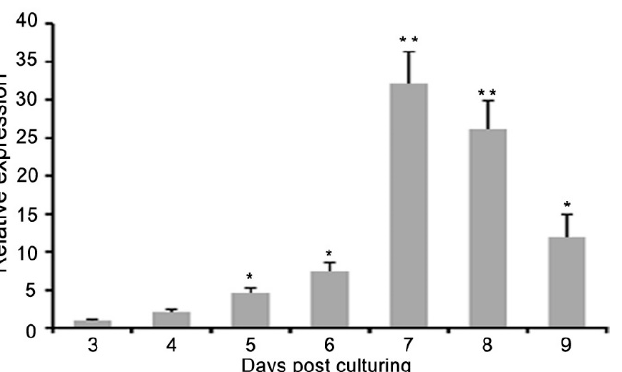
Figure 3. Transcript levels of VdSOD3 during culturing in Czapek medium (CM) from 3 to 9 days. The expression levels of VdSOD3 were calculated by the comparative Ct method with EF-1 α of V. dahliae as an endogenous control. The values are averaged and error bars represent standard deviations ( n = 3). Asterisks ** and * represent significant differences p < 0.01 and p < 0.05 by Student’s t -test, respectively.